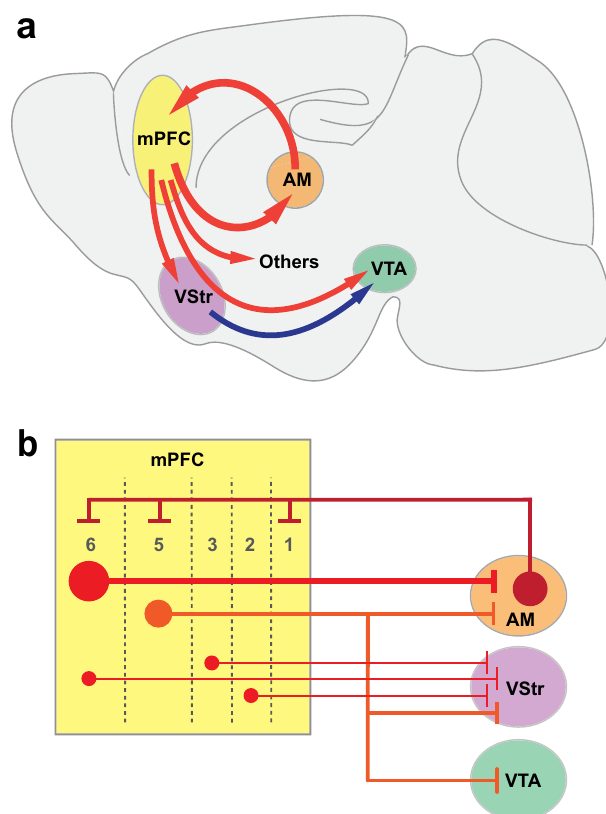
Fig. 9 The mPFC regulates goal-directed motivation and dopamine activity via multiple projection pathways. a Schematic drawing of the sagittal brain section showing the mPFC – AM loop and other key mPFC pathways to regions that participate in regulating goal-directed motivation and DA activity. b Schematic drawing showing a microcircuit model between the mPFC and its downstream projection regions of the AM, VStr, and